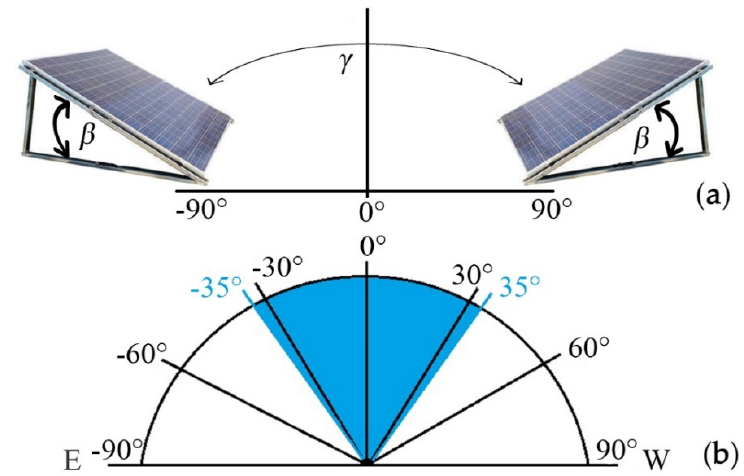
Figure 5. ( a ) The azimuth orientation of the model PV system; ( b ) The recommended orientation (azimuth angle marked in blue color) for southern Slovakia.